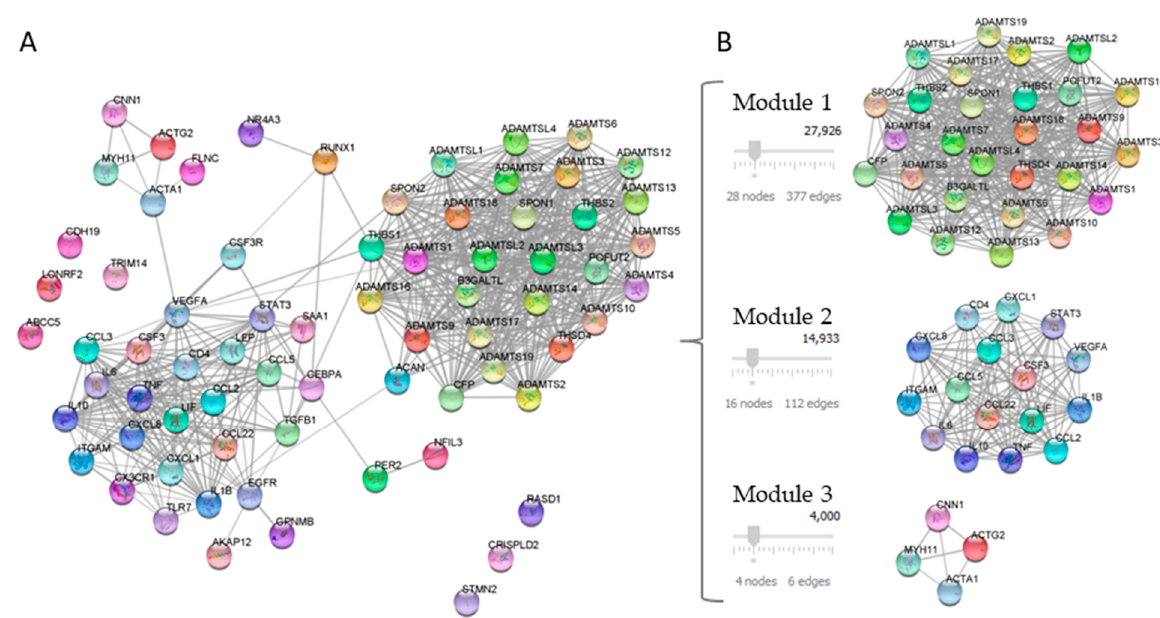
Figure 2. Analysis of the PPI network of DEGs. Panel ( A ) shows PPI network constructed with 21 common proteins between NAFLD and ATH. Panel ( B ) shows the PPI network modules identified using the MCODE plug-in.